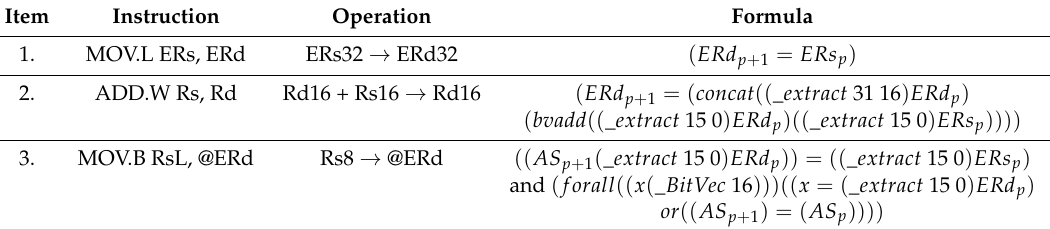
Table 1. Logical formulas of H8/3687 asembly instruction(SMT-LIB2